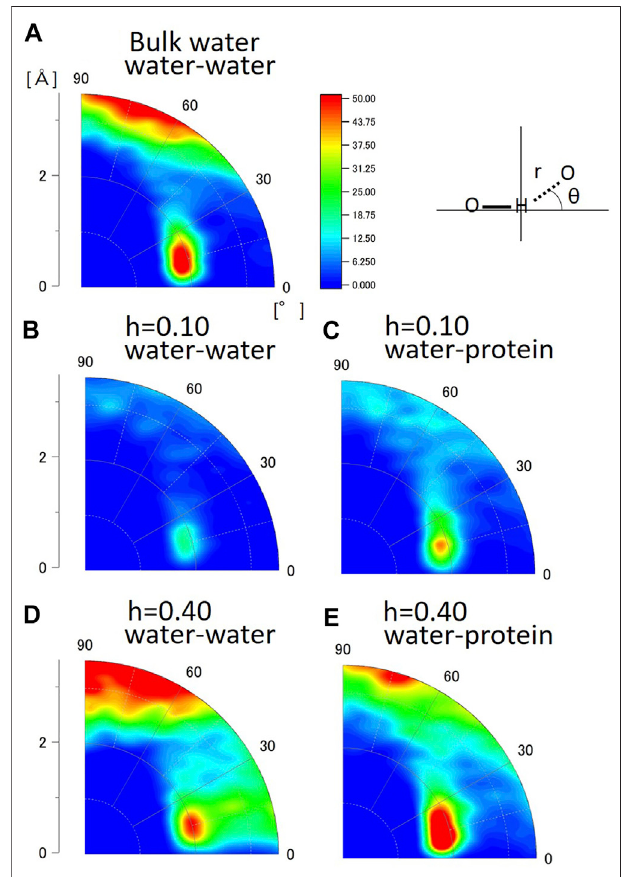
FIGURE 5 | Geometrical distribution of O-H ... O calculated from MD simulation (A) betweenwaterandwaterinbulkwater, (B) waterandwaterath (cid:1) 0.10(gwater/gprotein), (C) waterandproteinath (cid:1) 0.10(gwater/gprotein), (D) water and water at h (cid:1) 0.40 (g water/g protein), and (E) water and protein at h (cid:1) 0.40 (g water/g